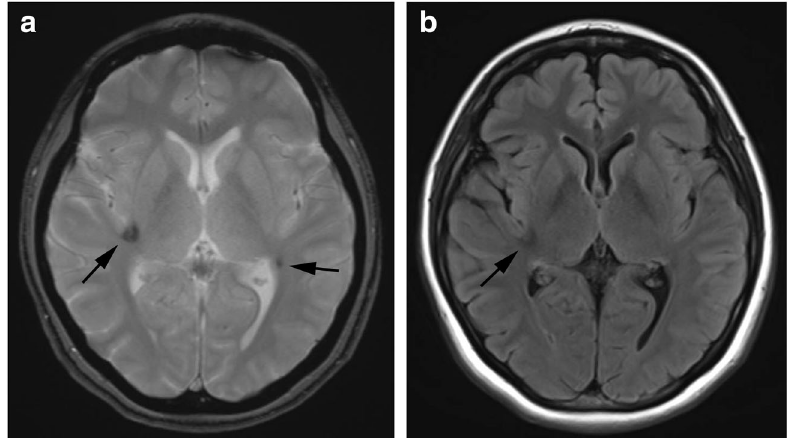
Fig. 10 Radiation induced focal haemosiderin deposition. A 29- year-old woman, who received radiation therapy for acute lymphocytic leukaemia, had no symptom. a AT2*-weighted image shows focal haemosiderin deposition in the right insular and left temporo-parietal lobe ( arrows ). b FLAIR image shows slight low intensity area in the right insular ( arrowheads ). Left temporo-parietal small lesion is not apparent ( arrow